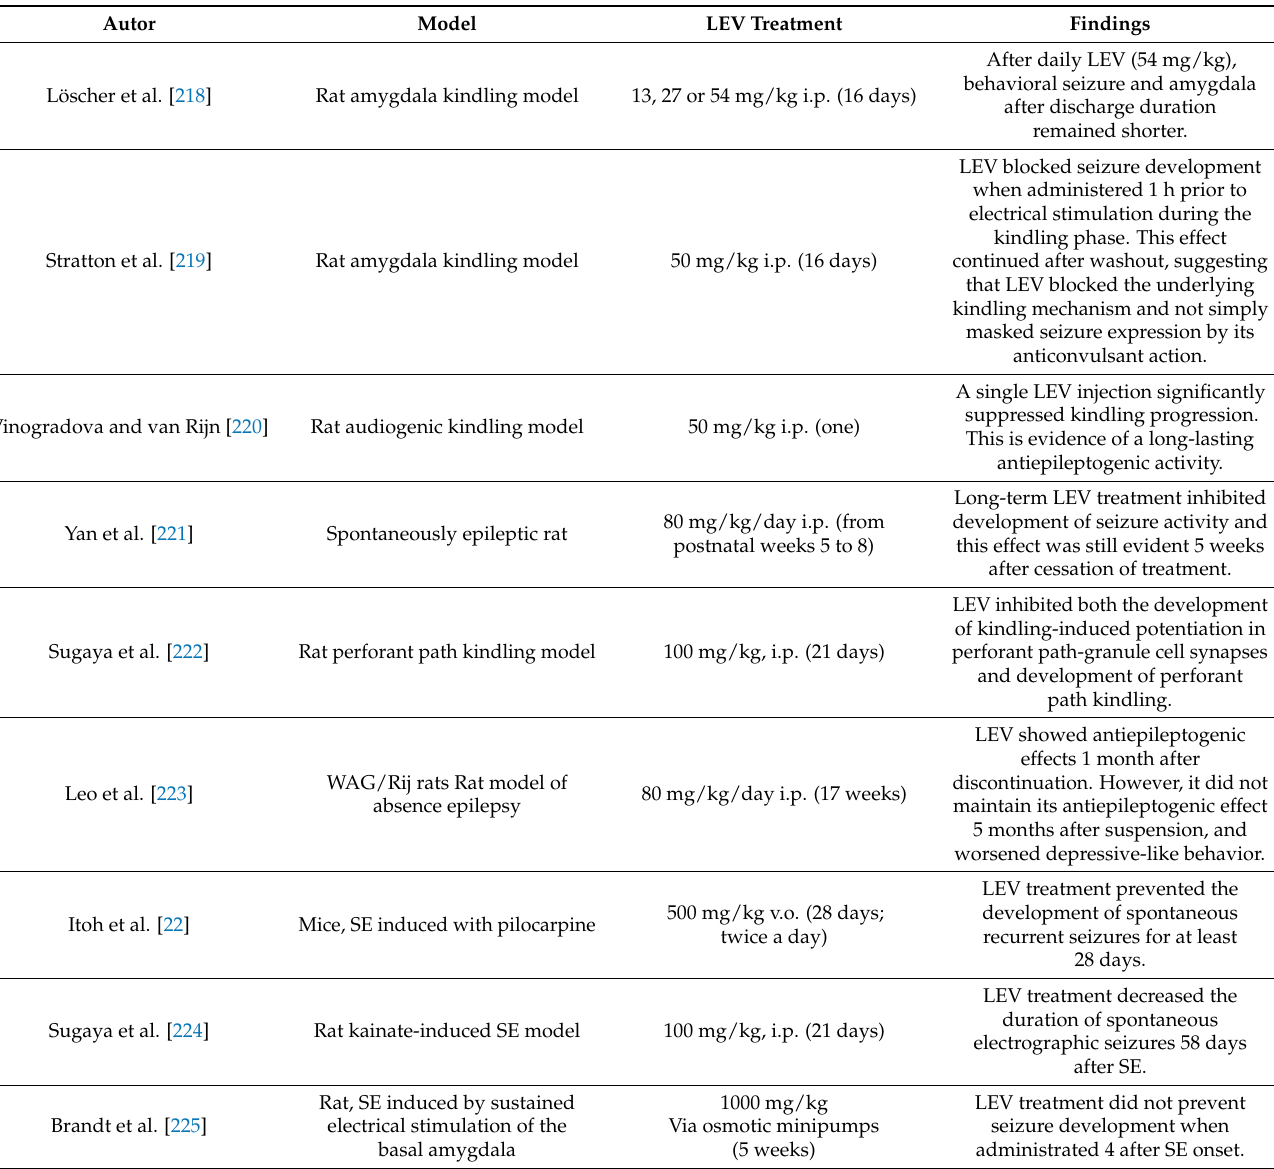
Table 1. The antiepileptogenic role of